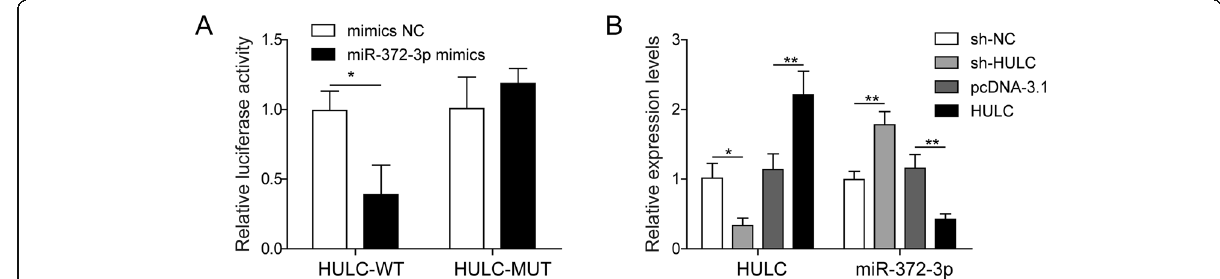
Fig. 3 HULC served as a ceRNA for miR-372-3p in osteosarcoma. The miR-372-3p mimics and luciferase reporter plasmids with wild-type or mutant HULC 3 ′ -UTR were co-transfected into U2OS cells. A dual luciferase reporter assay was performed to explore the direct binding relationship between HULC and miR-372-3p (A). U2OS cells were transfected with HULC-targeting shRNA (sh-HULC), negative control shRNA (sh- NC), pcDNA3.1-HULC overexpression vector (pcDNA-HULC) or empty vector plasmid (pcDNA-3.1), and then qRT-PCR was performed to evaluate the relative expression levels of HULC and miR-372-3p (B). Data are shown as the mean ± SD. * p < 0.05, ** p <